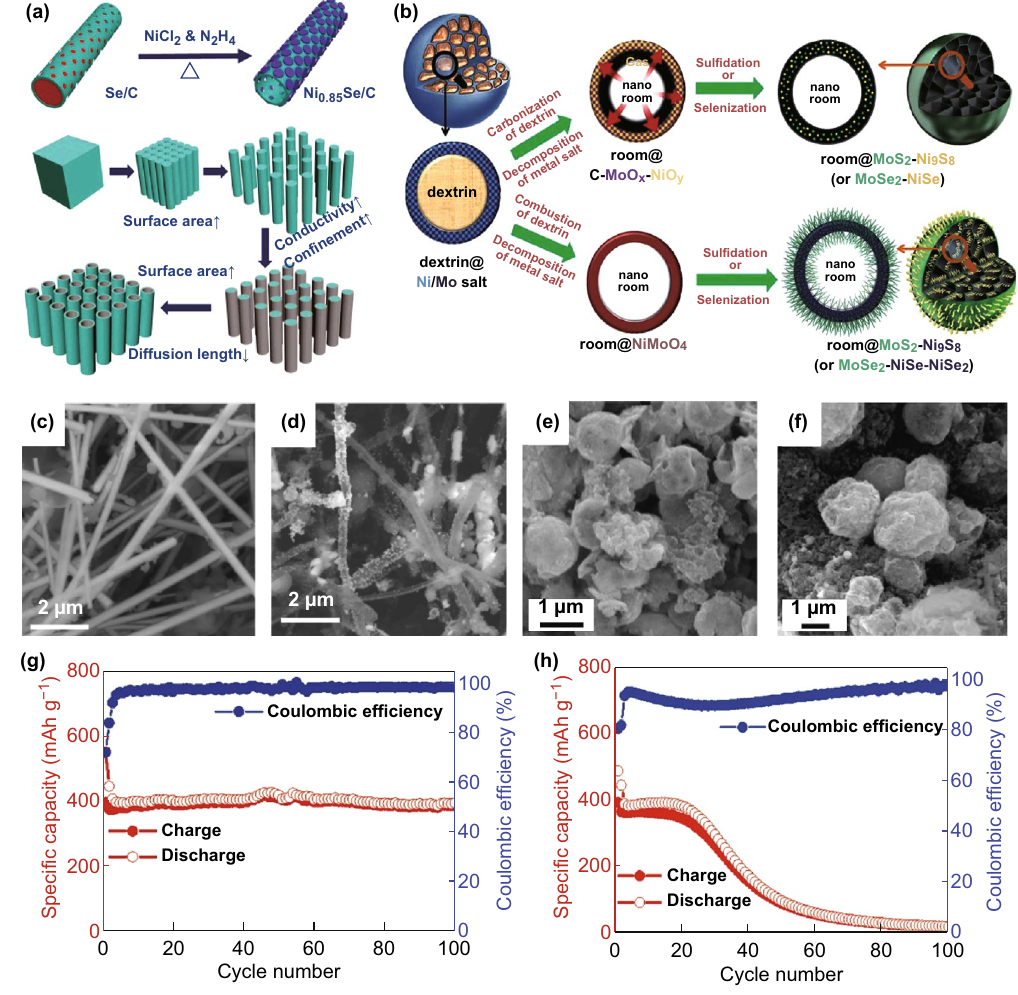
Fig. 7 a Self-template method schematic and advantages of carbon-supported hollow nanowires on bulk materials. b Formation mechanism of hollow nanowires in MoS 2 –Ni 9 S 8 –C, MoSe 2 –NiSe–C, MoS 2 –Ni 9 S 8 , and MoSe 2 –NiSe 2 microspheres. SEM images of c Se/C and d Ni 0.85 Se/C hollow nanowires at different magnifications. e Morphologies of the multiroom-structured MoX 2 -NiX y (X ¼ S or Se) after 100 cycles for MoSe 2 – NiSe–NiSe 2 microspheres. f Morphologies of the multiroom-structured MoX 2 –NiX y (X ¼ S or Se) after 100 cycles for MoSe 2 –NiSe–C micro- spheres. g Specific capacity and coulombic efficiency of Ni 0.85 Se/C hollow nanowires. h Special ability and coulombic efficiency of Ni 0.85 Se nanoparticles at 0.2 C. Adapted from Refs. [56, 57] with permission. Copyrights: 2017, Wiley-VCH and 2017, The Royal Society of